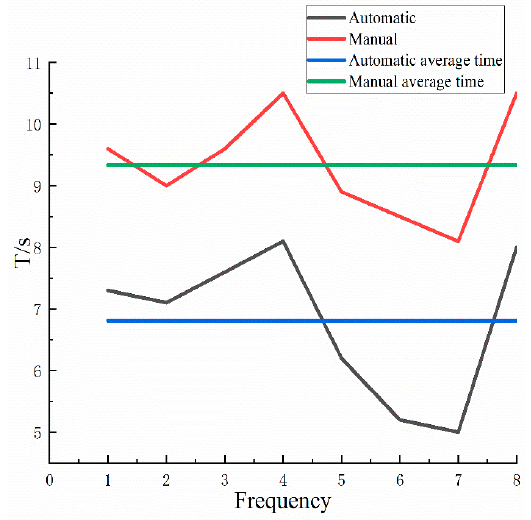
Figure 11. Comparison of automatic and manual levelling time.